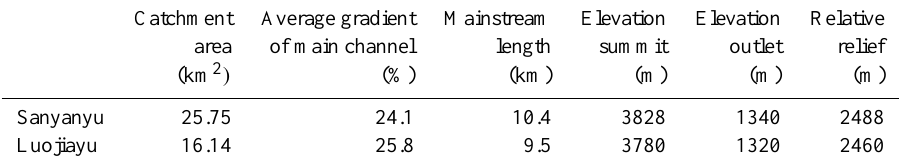
Table 1. Basic morphologic parameters of Sanyanyu and Luojiayu catchments. Catchment